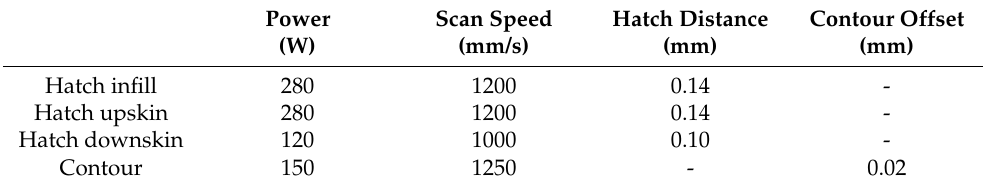
Table 3. Exposure parameters for Ti6Al4V.